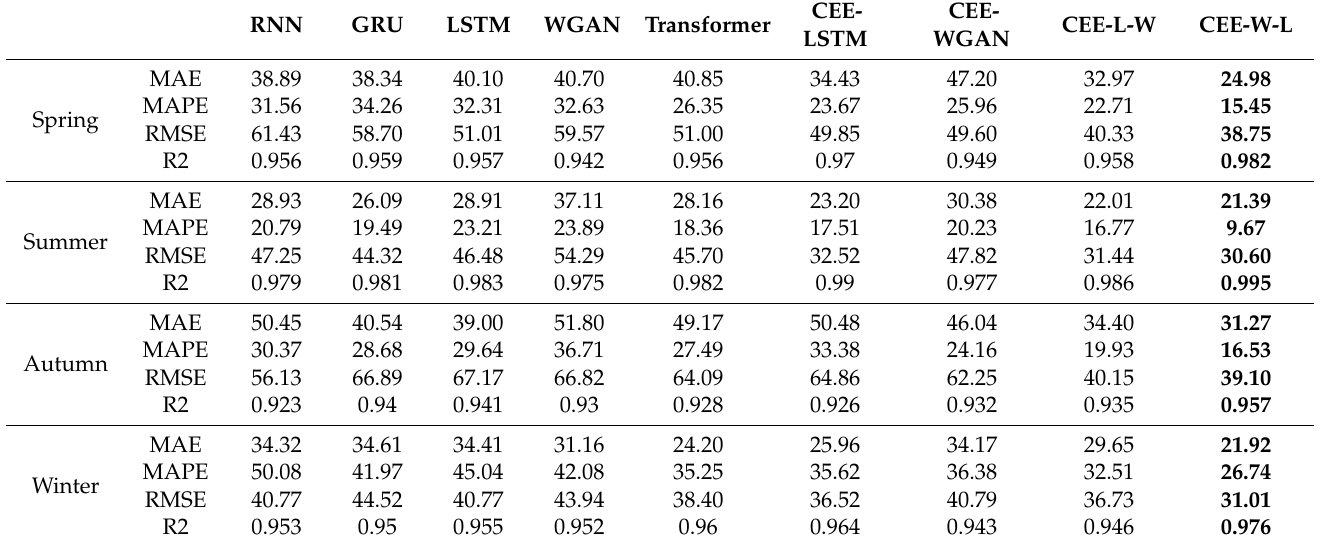
Table 5. Quantitative comparison of the four evaluation indicators of the proposed model and eight comparison models for four